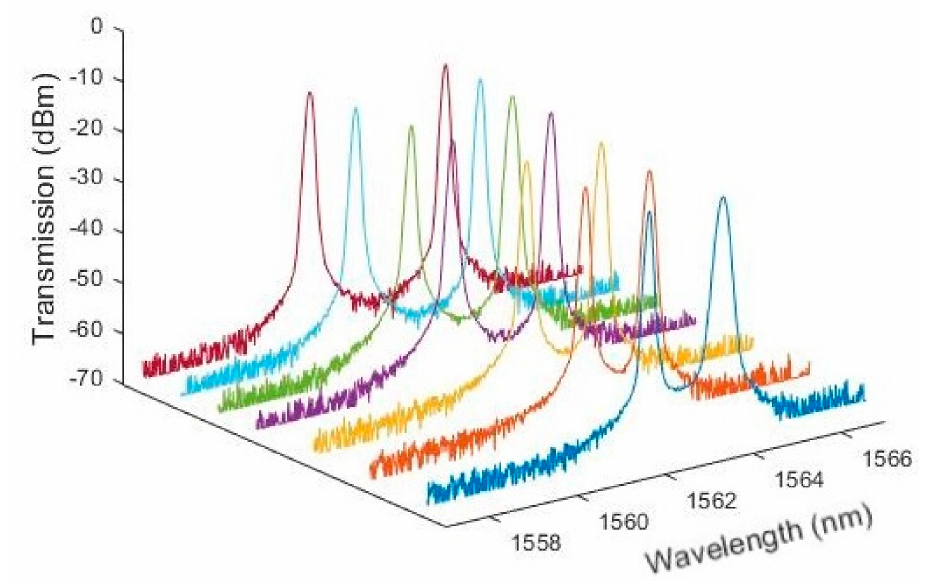
Figure 4. Tunable dual-wavelength laser